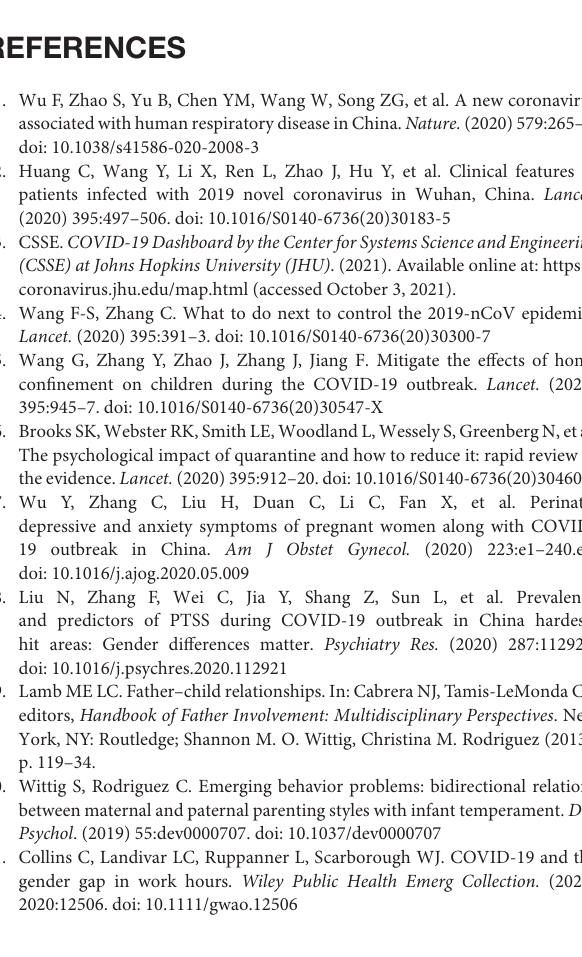
Supplemental Table 2.2 | The adjusted relationships between family contradiction and child over-use of electronic devices. Adjusted for child age,